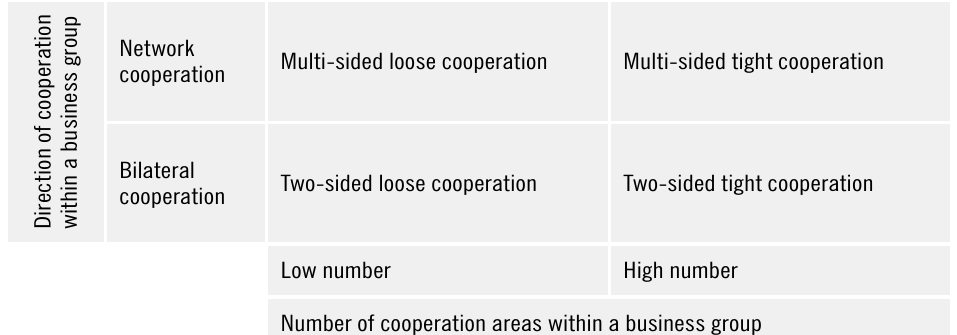
Table 2. Generic models of cooperation within a business